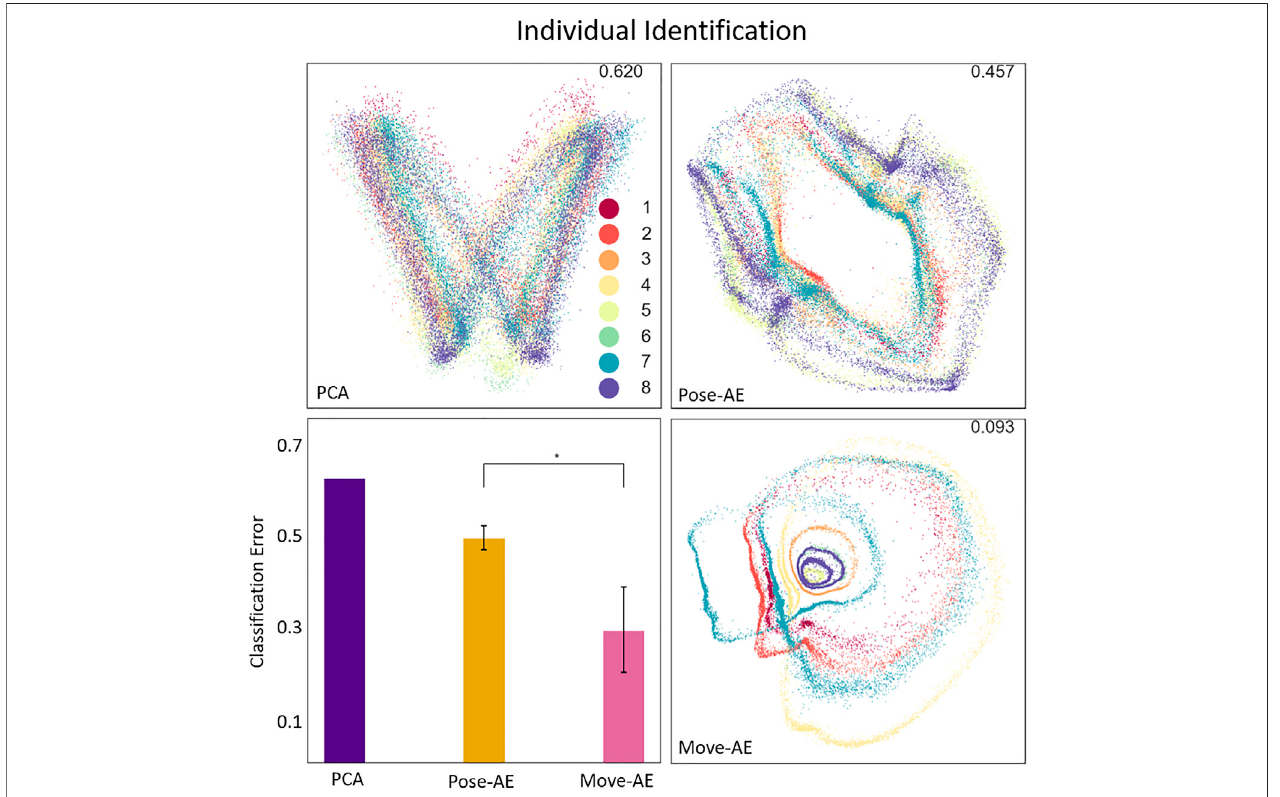
FIGURE5| Thethreepanesdisplaythebestperforminglatentspaceoftheirrespectivemethod.Theplotteddataiscoloredbyoneofeightindividualsubjects.The classi fi cation error for the best performing model is included in the top-right of each plot. The bottom-left pane shows the results of an individual-speci fi c classi fi er SVM trained on the latent spaces for each method. Note that the Move-AE latent space here is a well-performing outlier, though visual inspection of the other latent spaces con fi rm the general behavior of separately embedding individuals.